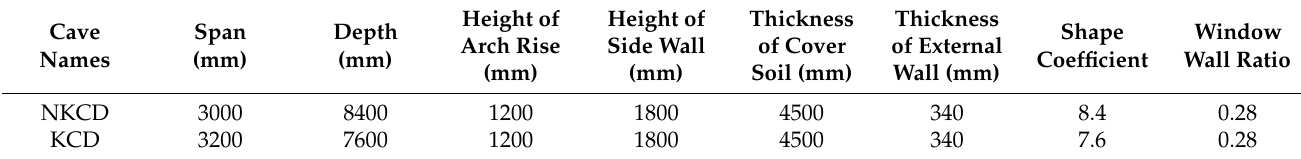
Table 2. Building information of two cave rooms with same orientation.